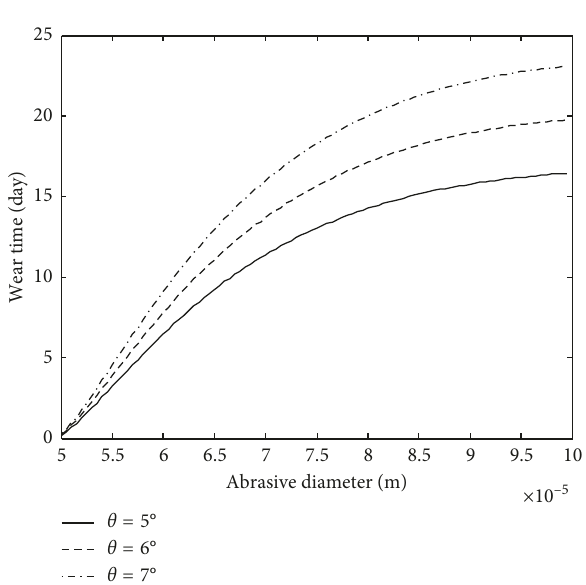
Figure 9: Wear time change